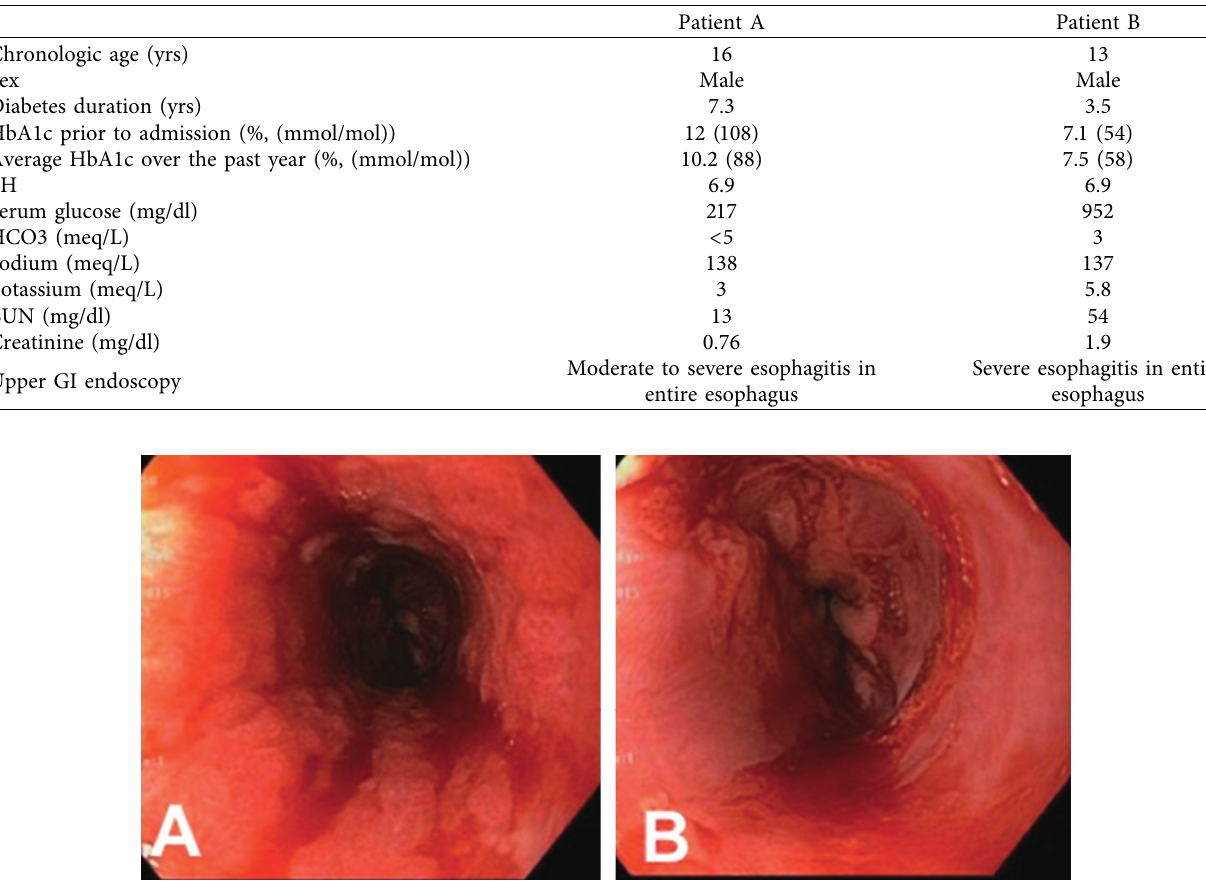
Figure 1: (a) Severe mucosal abnormality with erythema, friability (with spontaneous bleeding), and hemorrhagic appearance in the middle and distal esophagus. (b) Mucosal friability and sloughing in the distal esophagus (both images from Patient